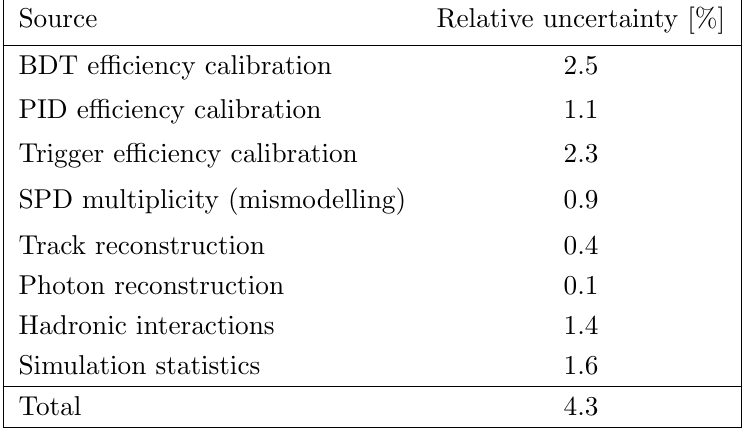
(cid:17) 0 K + ) =(cid:15) ( B 0 (cid:17) 0 (cid:30) ). s ! !